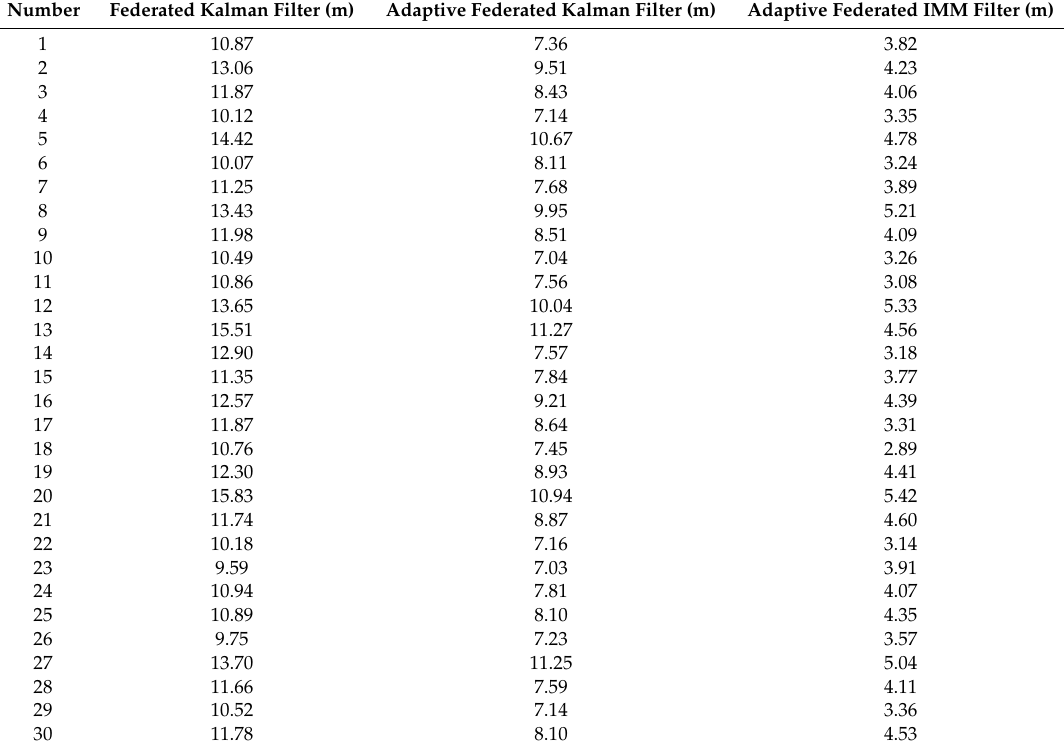
Figure 25. The mean absolute errors (MAEs) of position errors in 30 groups of integrated navigation experiments. Table 4. The MAEs of position errors (m) in 30 groups of integrated navigation experiments.